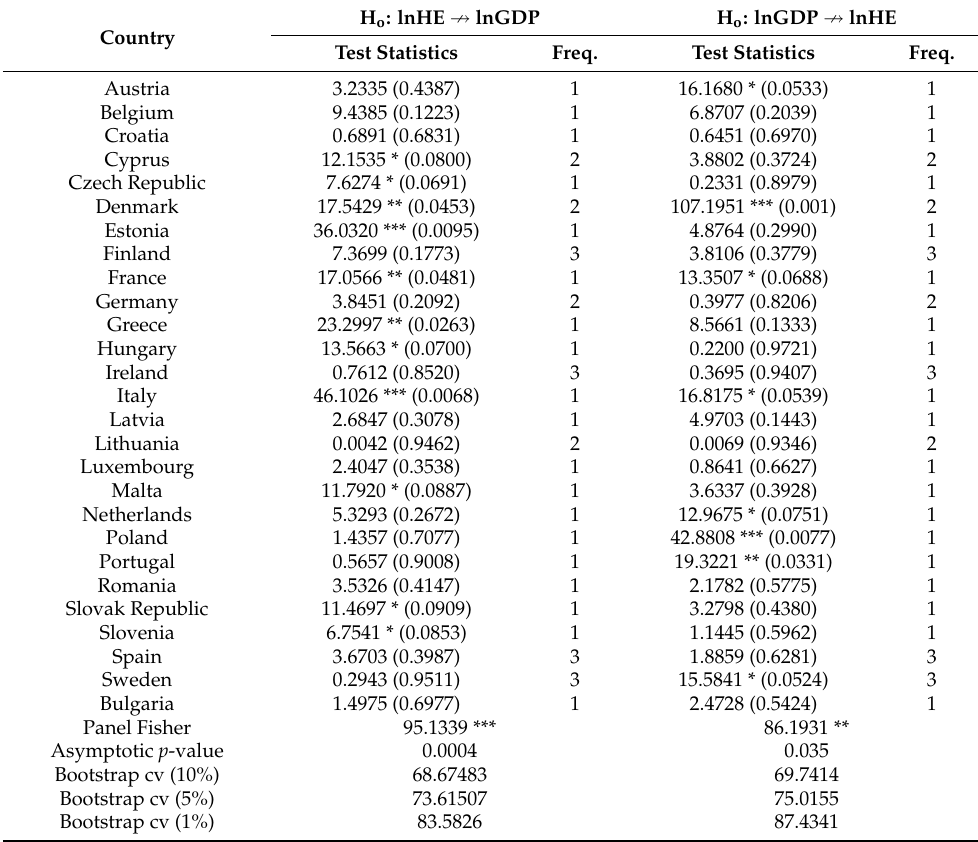
Table 4. Panel Fourier Causality Test